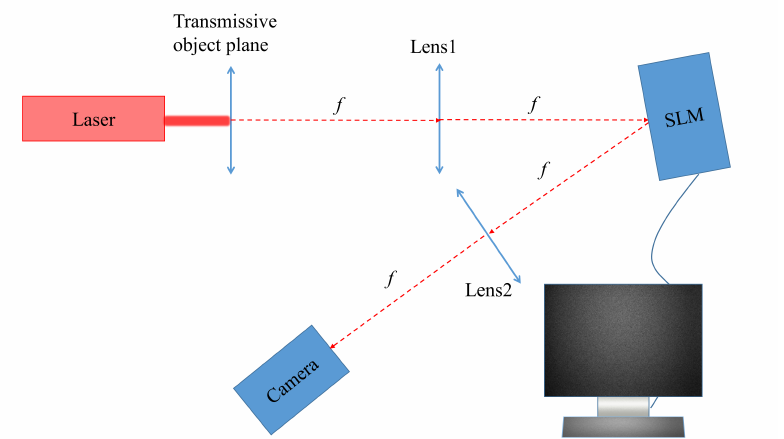
Figure 11. Super-oscillatory mask (grating) with coefficient rings.